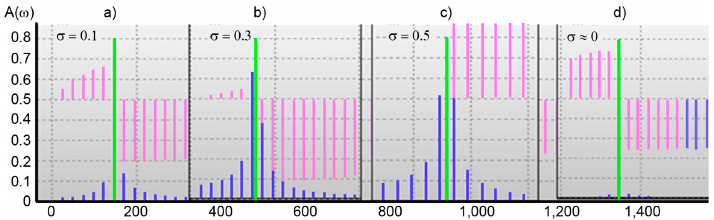
Figure 7. DFT leakage effect elimination by solving Equation (6), (a) σ = 0.1, (b) σ = 0.3, (c) σ = 0.5, and (d) σ = 0.